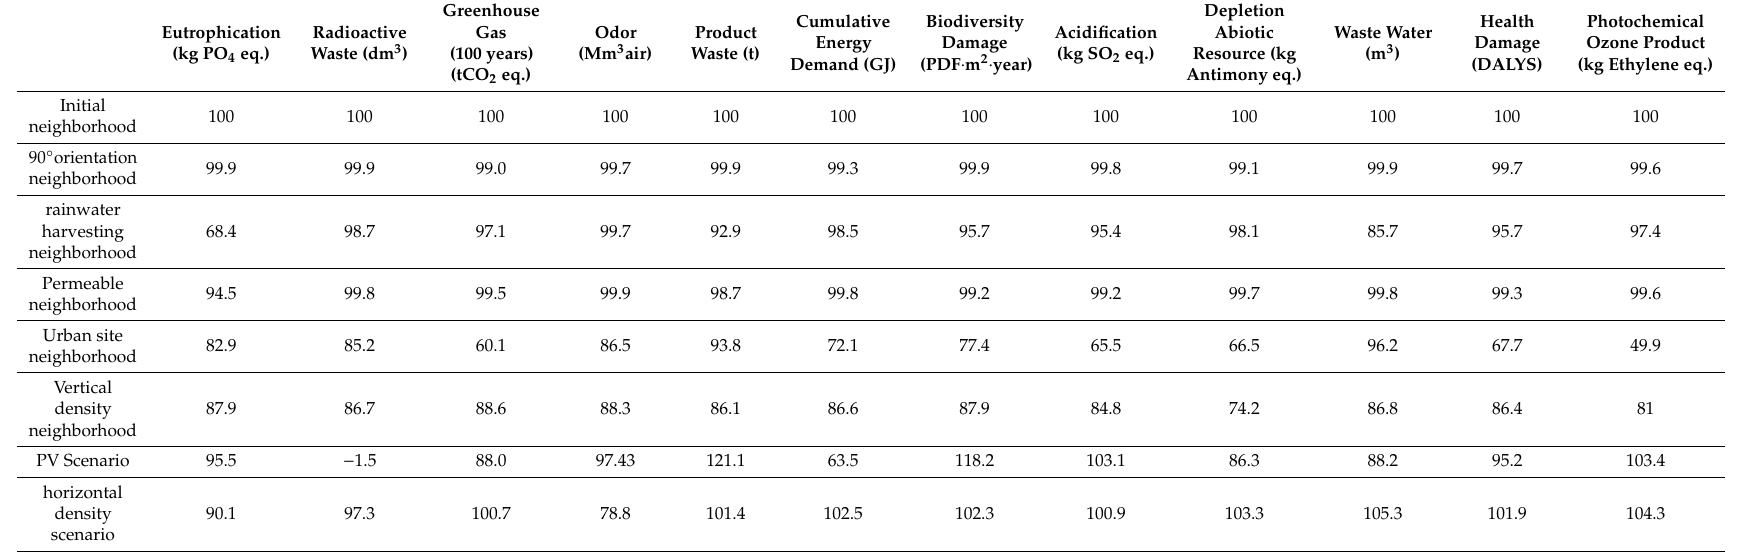
Table 12. Changes in environmental indicators for all scenarios considered compared to the initial scenario (functional unit: occupant). Eutrophication (kg PO 4